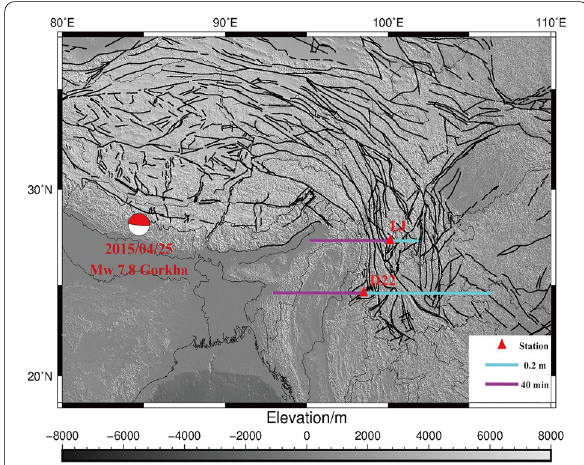
Fig. 1 Map showing the locations of the D22 well and LJ well (red solid triangles). ‘Beach ball’ shows the epicenter and focal mechanism of the 2015 Mw 7.8 Gorkha earthquake (Avouac et al. 2015). Black lines denote the location of surface faults on the Chinese mainland (Deng et al. 2006). The blue and purple lines indicate the variation amplitude and duration of water-level responses to The Gorkha earthquake,